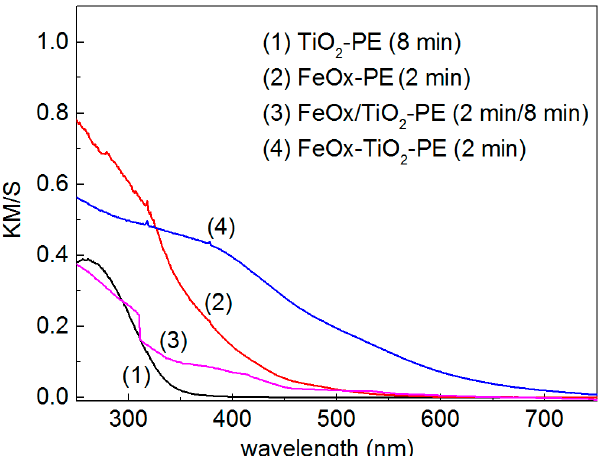
Figure 5. Diffuse reflection spectroscopy (DRS) showing the Fe(III) shifting band gap excitation of TiO 2 to the visible region in the samples: (1) TiO 2 –PE (8 min), (2) FeO x –PE (2 min), (3) sequentially sputtered TiO 2 /FeO x –PE (2 min FeO x , 8 min TiO 2 ), and (4) co-sputtered TiO 2 —FeO x –PE (2 min). Reprinted with permission from [39]. Copyright 2015 RSC.